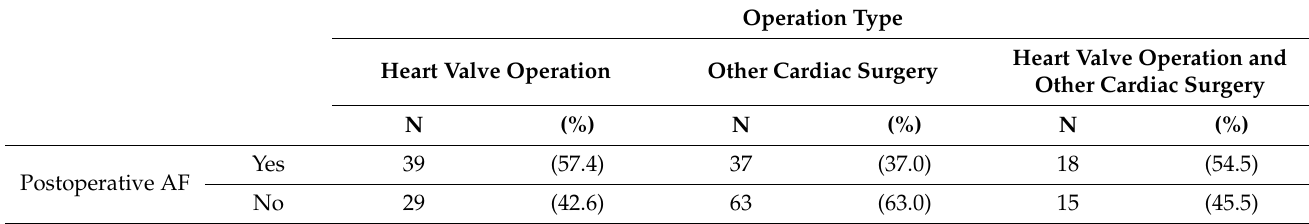
Table 5. Prevalence of postoperative AF by type of